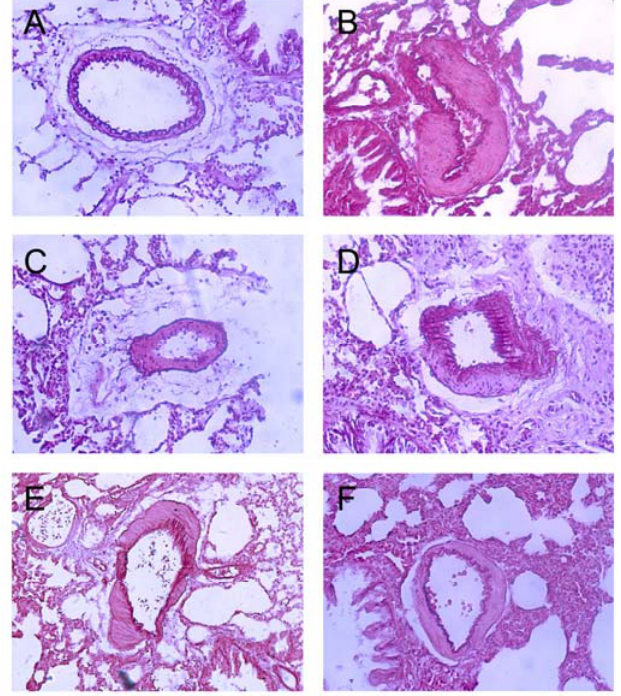
Figure 3. Van Gieson counterstaining showing elastic fibers during chronic